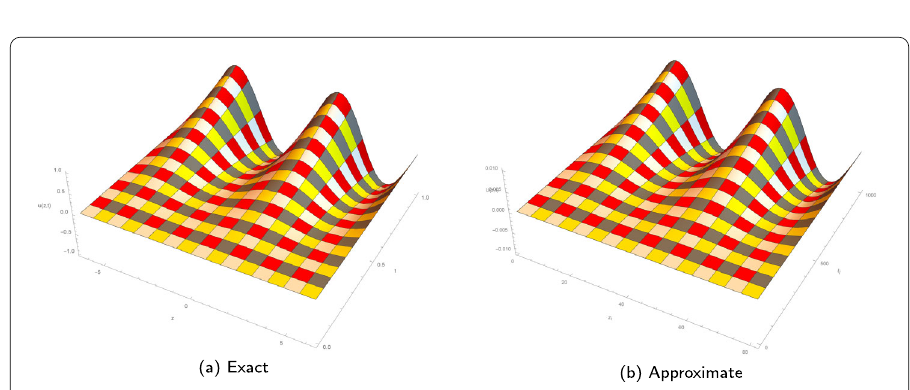
Figure 11 Exact and approximate solutions for Example 3, when N = 80, α = 0.5, t = 1, (cid:3) t = 0.001 and –2 π ≤ z ≤ 2